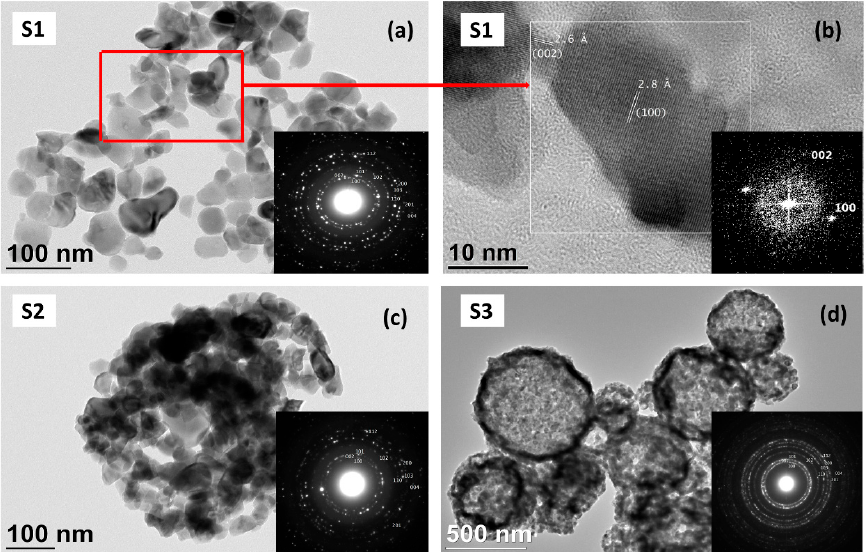
Figure 4. High Resolution Transmission Electron Microscopy (HRTEM) micrographs and electron diffraction ring pattern of S1 ( a ), HR-TEM micrographs and electron diffraction spot pattern S1 ( b ), HRTEM micrographs and electron diffraction ring pattern of S2 ( c ) and S3 ( d ).